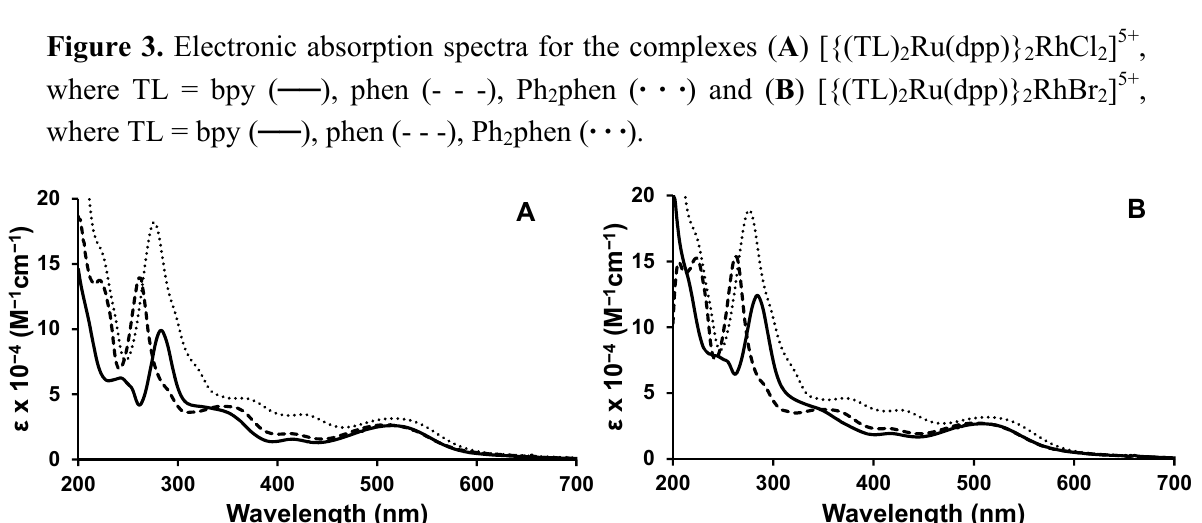
Ru(dpp)} RhCl ] 5+ , 2 2 2 Ru(dpp)} RhBr ] 5+ 2 2 2